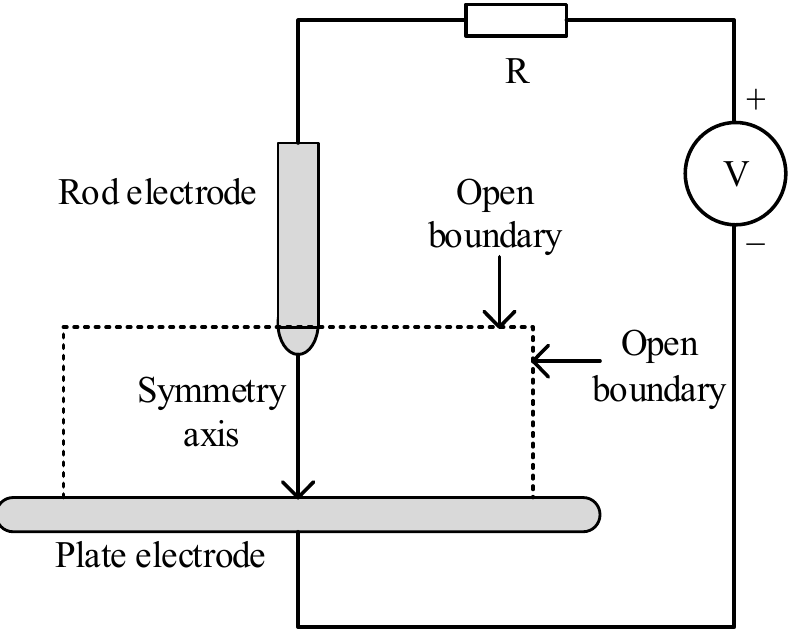
Figure 1. Geometric structure diagram of bar-plate model.